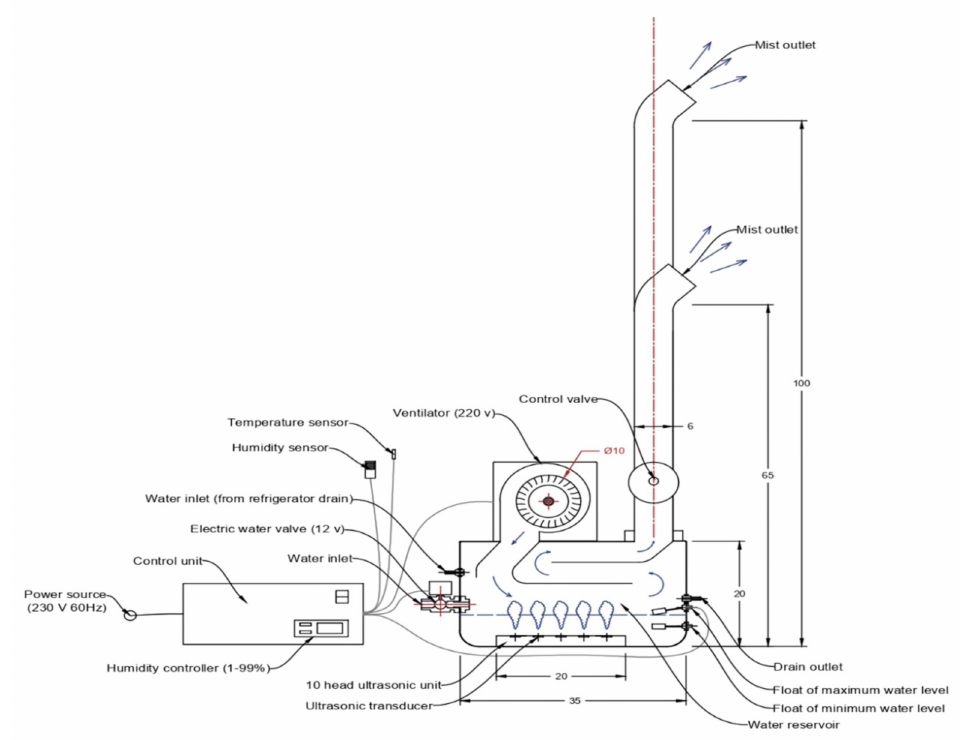
Figure 1. Schematic diagram of the designed ultrasonic humidifier showing the different parts (dimensions in